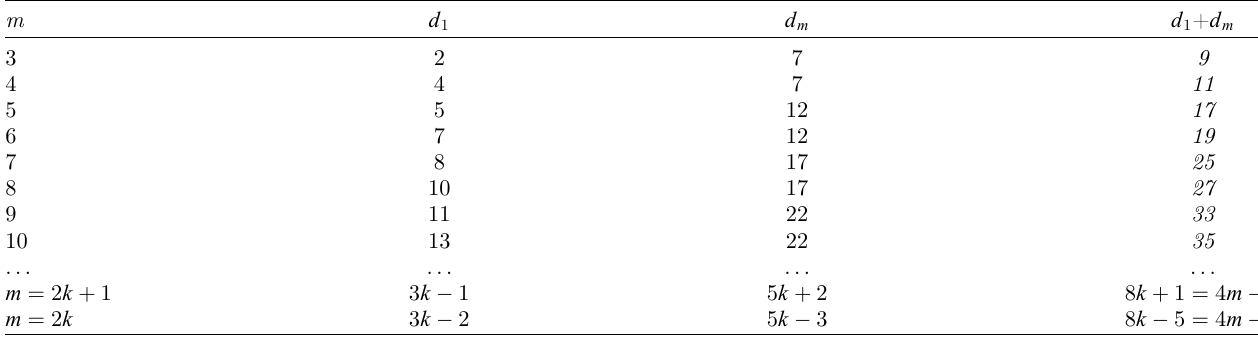
Table 2. Number of cuts for smallest and largest divisors for m